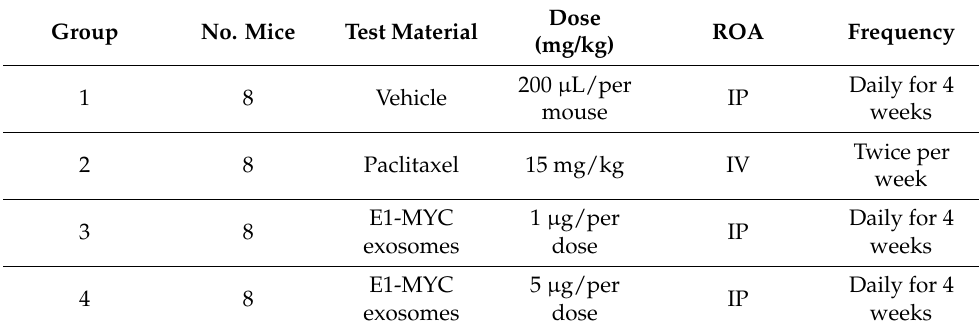
Table 2. Treatment regime of tumor model. Group treatments of animals following development of